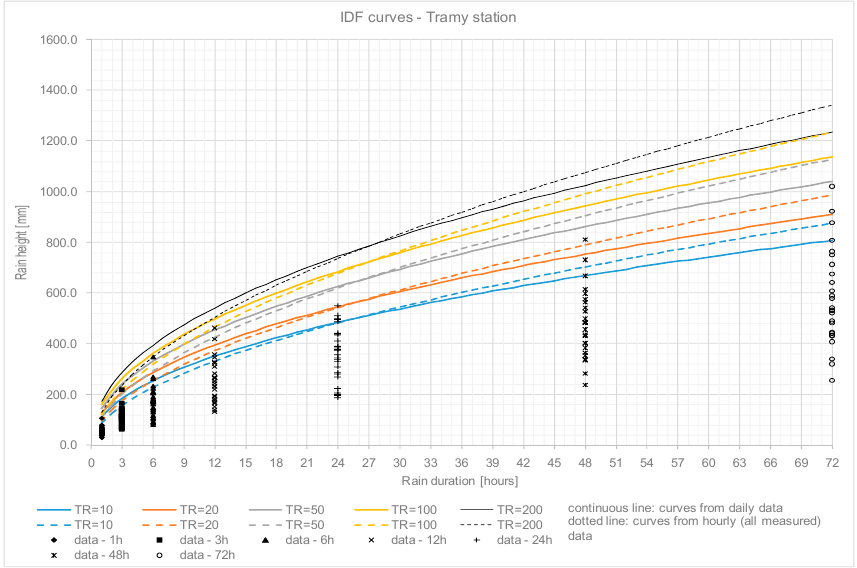
Figure 8. Confrontation between curves obtained from hourly and daily data at Tramy station.